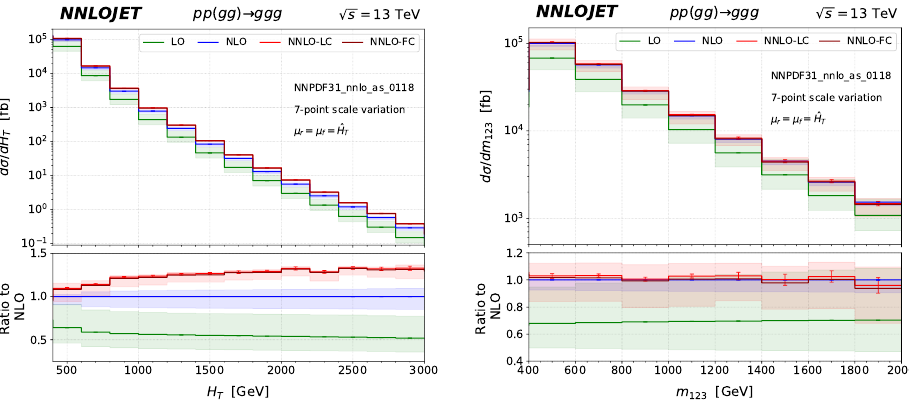
Figure 6 . Gluons-only three-jet production cross section differential in H T (left) and m 123 (right) up to NNLO. The NNLO-LC band corresponds to the leading-colour only contributions at NNLO, the NNLO-FC line includes subleading colour contributions except for the finite parts of the two-loop virtual